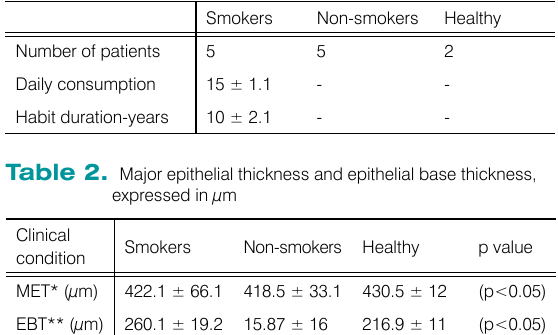
Figure 3 . Normal gingival